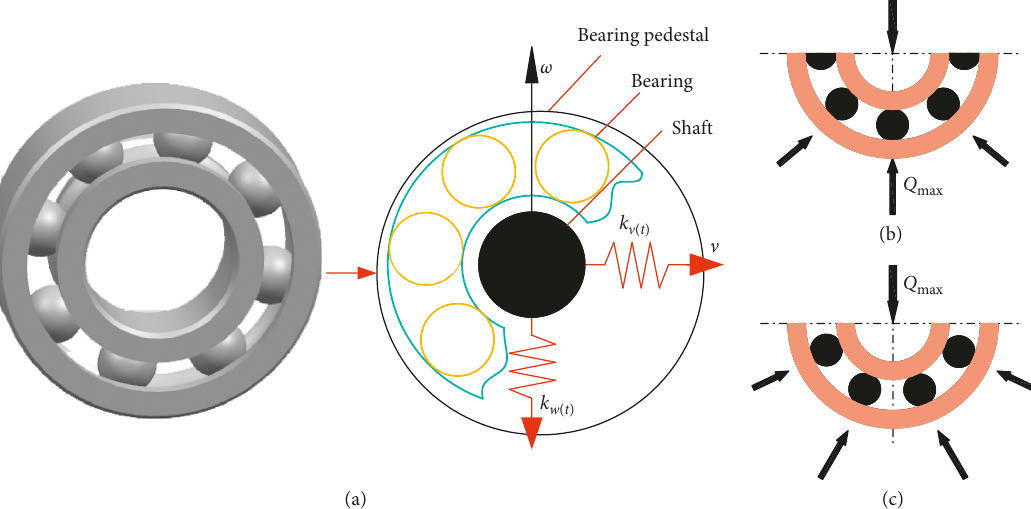
Figure 6: The dynamics model of deep groove ball bearing and two bearing forms. (a) The dynamics model of deep groove ball bearing. (b) Odd pressure state. (c) Occasional pressure state.